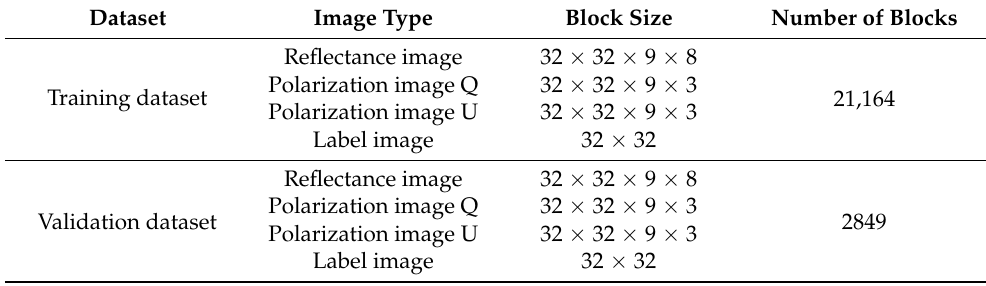
Table 2. Detailed information of